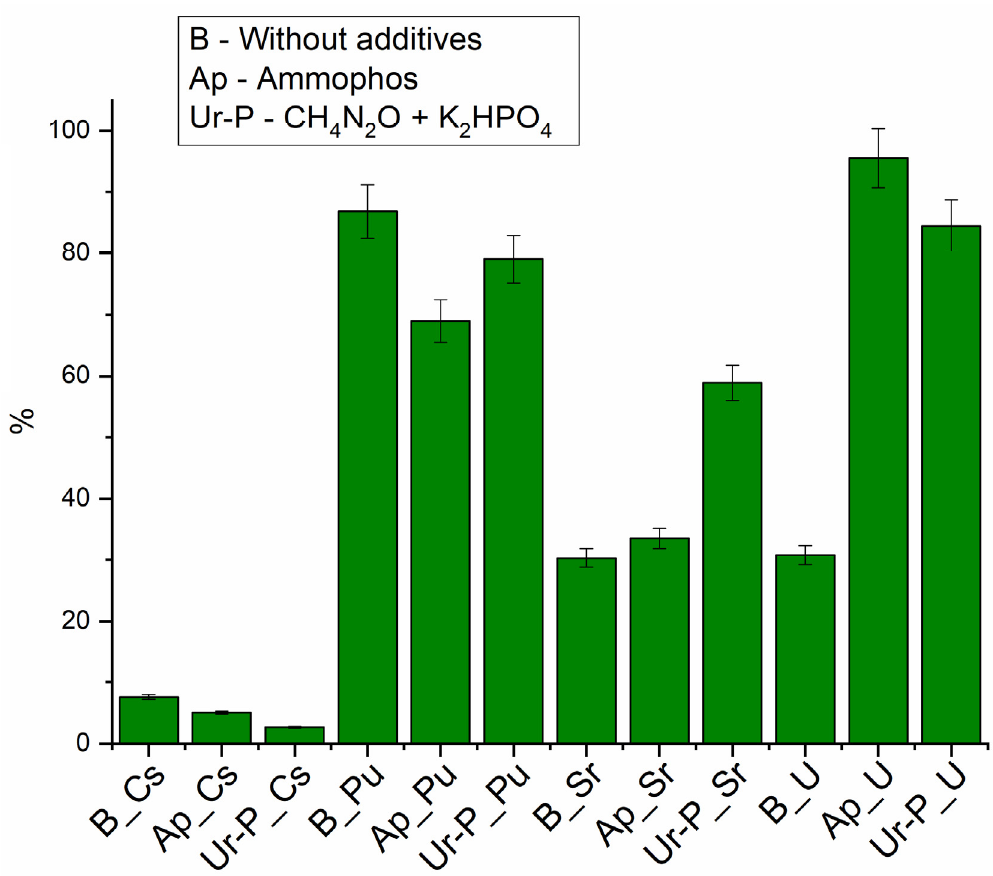
Figure 4. Efficiency of radionuclide removal from the liquid phase, 36 days.